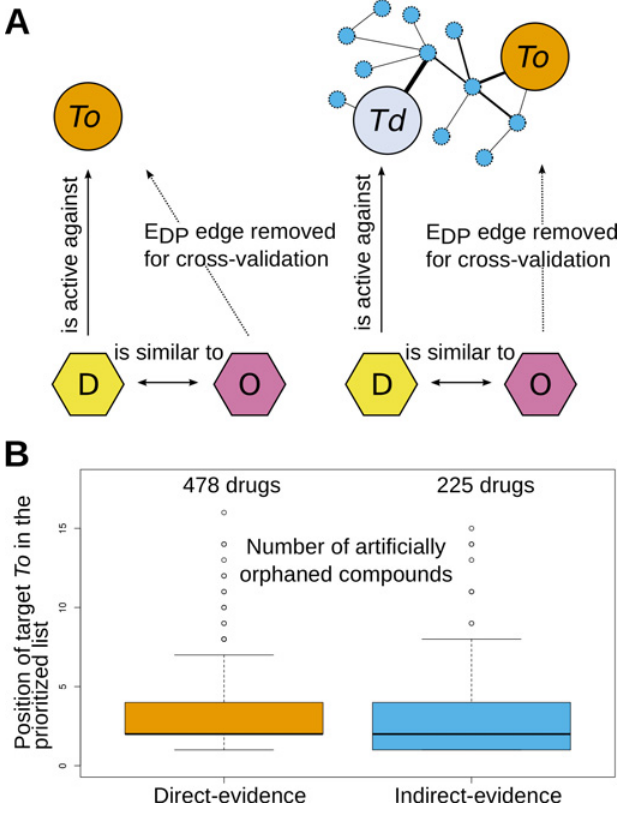
Fig 4. Inference of targets of orphaned compounds. a, top: Schematic view of two different ways in which the algorithm can find the correct target for artificially orphaned compounds. O = orphan compound; D = bioactive drug/compound which is a first neighbor of O in the D-layer; T o , known target of the artificially orphaned compound O; T d , known target of compound D. Arrows represent significant similarity relationships between compounds or significant bioactivity links between a target and a compound. Dashed lines connecting compounds and targets represent the original E DP edges that were removed for the cross- validation procedure. a, left: direct inference, compound D has a bioactivity link to T o (special case, T o = T d ). a, right: indirect inference, compound D lacks bioactivity links against T o , but a high-scoring path connects T d to T o in the projected PP-layer. b, bottom: boxplots showing the distribution of the position of T o targets in the rankings for 703 orphaned compounds. b, left: boxplot for cases that fell in the direct inference class (478 compounds). b, right: boxplot for cases in the indirect inference class (225